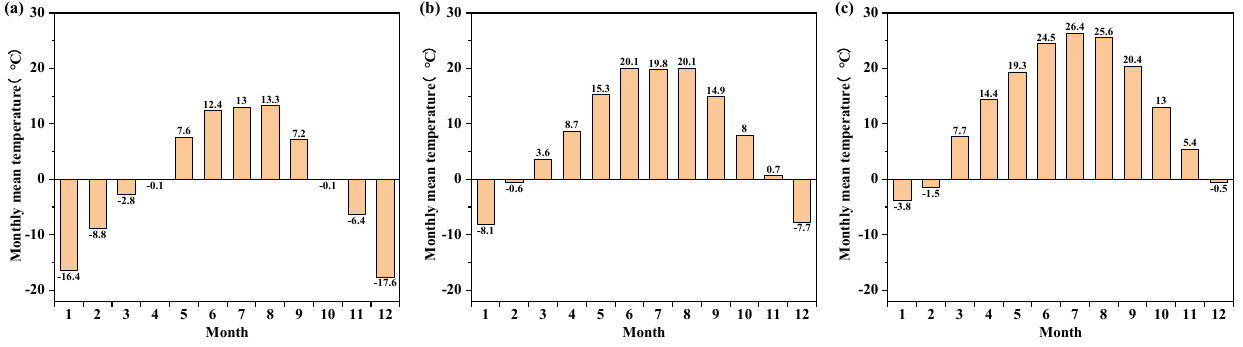
Figure 1. Monthly mean temperature ( a ) 2177.5 m; ( b ) 950 m; ( c ) typical year.